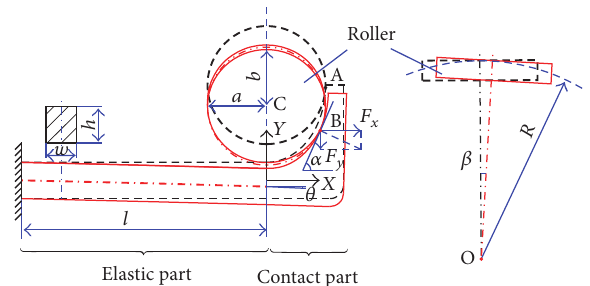
Figure 2: The schematic diagram of force analysis of the proposed